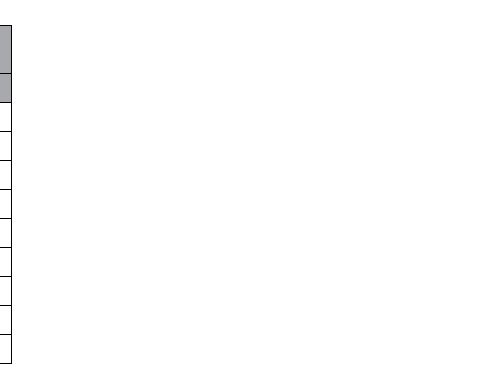
Figure 1. The lowest energy structures of neutral, cationic and anionic Cu n + 1 and Cu n S (n = 1–12) clusters. The purple and black balls represent sulfur and copper atoms, respectively.